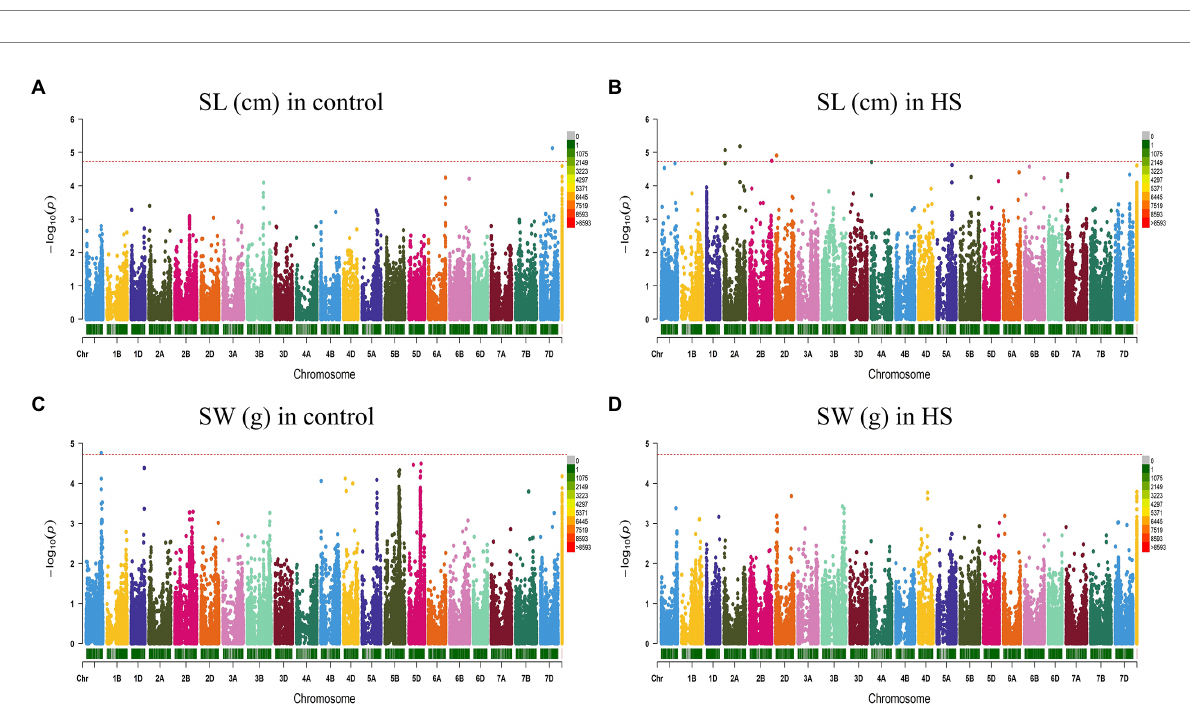
FIGURE 4 Manhattan plot showing density of SNP markers associated with shoot length (A) control condition; (B) HS condition, shoot weight (C) control condition; (D) HS condition.